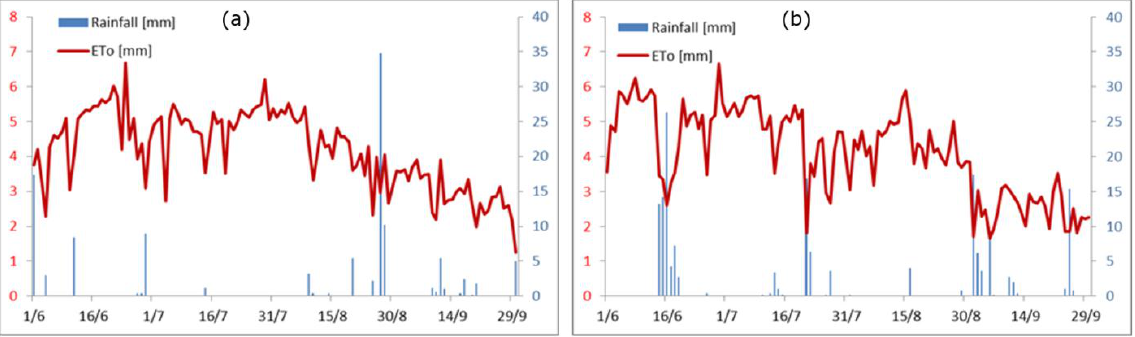
Figure 5. Seasonal trends of ET 0 and rainfall events during the growing season for the years 2013 ( a ) and 2014 ( b ).